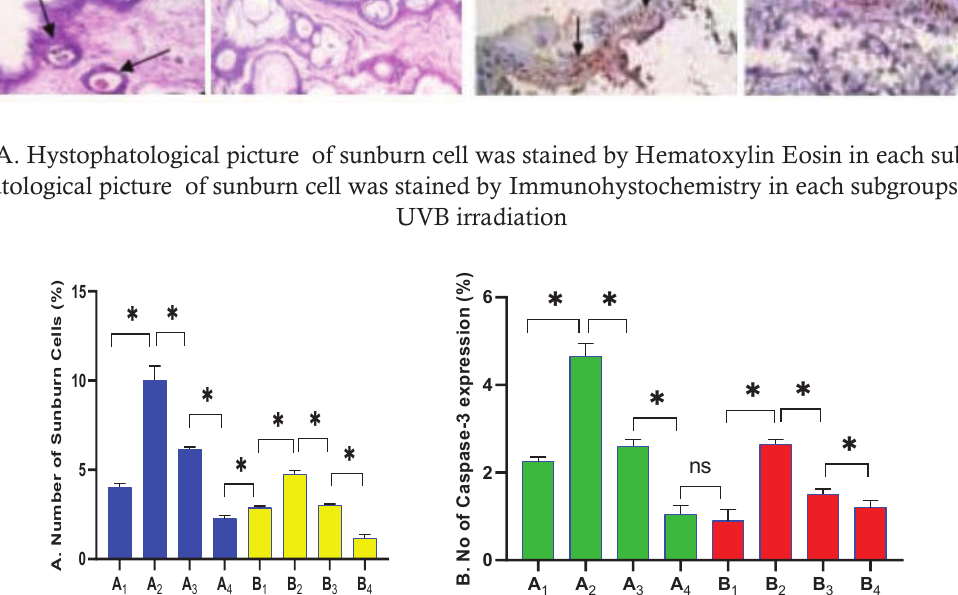
Figure 2. A. Number of sunburn cells in each groups; B. Number of caspase-3 expression in each group. Post